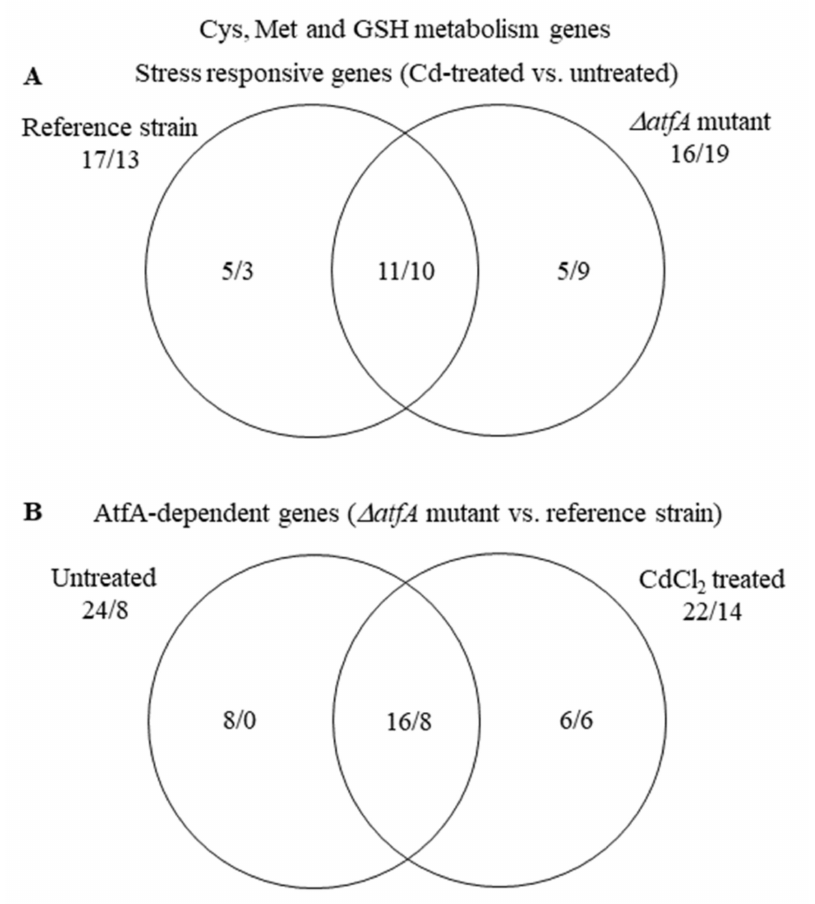
Figure 4. Distribution of stress responsive “Cys, Met and GSH metabolism” genes between the THS30 reference strain and the TNJ92 ∆ atfA mutant ( A ) as well as of the AtfA-dependent “Cys, Met and GSH metabolism” genes between the untreated and CdCl 2 -treated cultures ( B ). Figures represent the number of up-regulated/down-regulated genes. Further data on this gene group are available in Table